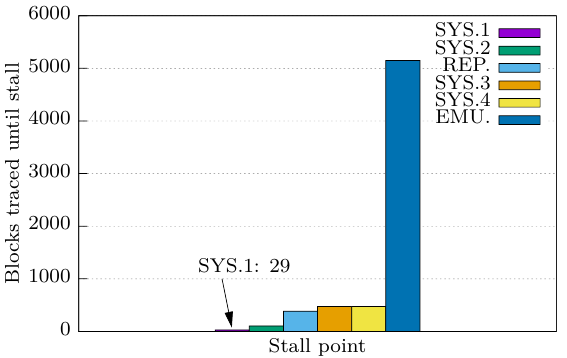
Figure 7: Traced block coverage (unique blocks) for BCM firmware for each stall point; tracing halted when buffer capacity (1MB) reached. After providing stimulus at each stall point (SYS.N, REP.), we are able to emulate the device firmware